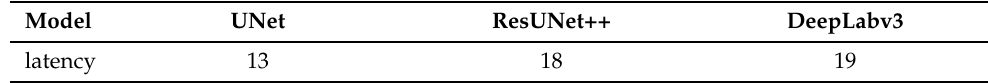
Table 5. The average time taken to segment a X-ray